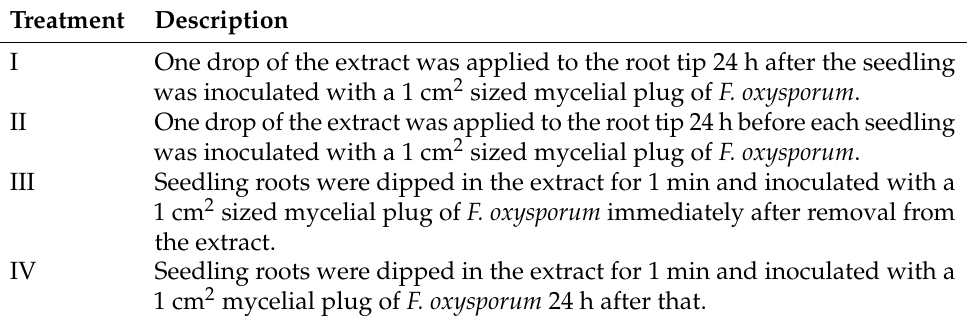
Table 1. Treatments of extracts application to the seedlings’